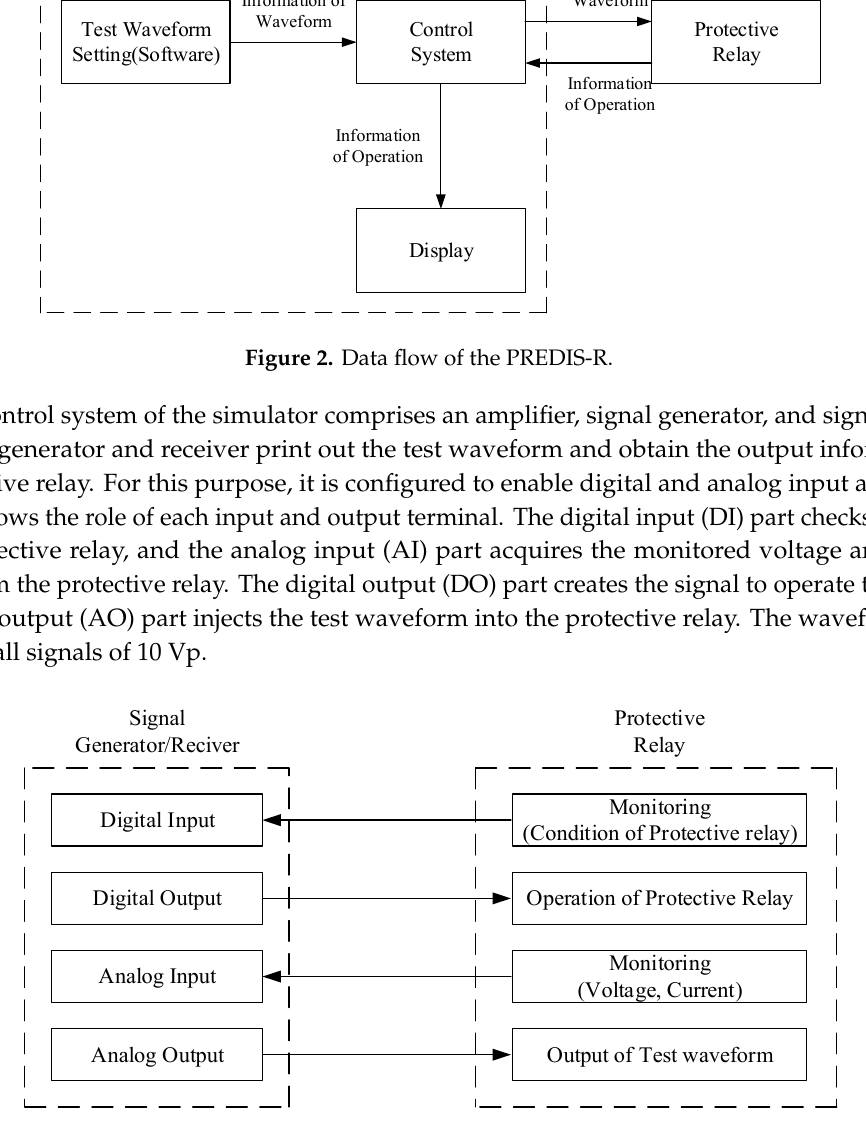
Figure 3. Signal generation and each function of the collecting part.